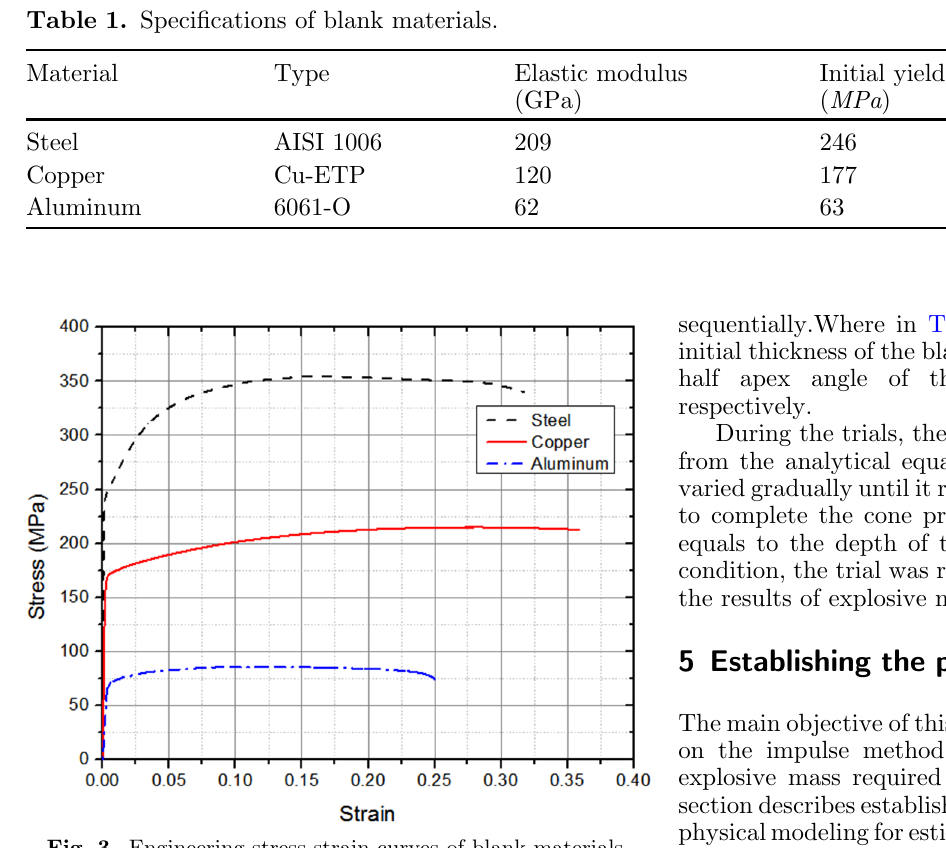
Fig. 3. Engineering stress-strain curves of blank materials.